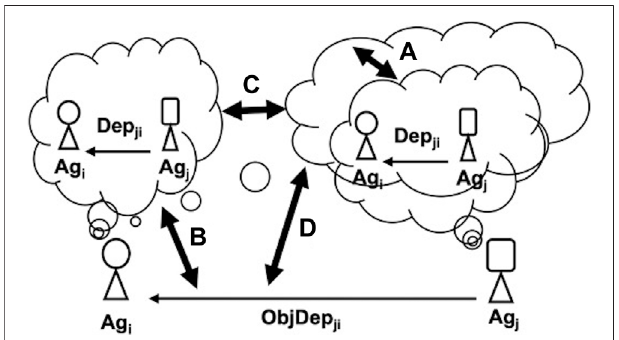
FIGURE 8 | Dependence of Ag j from Ag i on the task τ ’ . (A) comparison on how it is believed by Ag j and how Ag i believes it is believed by Ag j ; (B) comparison on how it is believed by Ag i and objective reality; (C) comparison on how Ag i believes it isbelieved by Ag j and how it isbelieved by Ag i ; (D) comparison on how Ag i believes it is believed by Ag j and objective